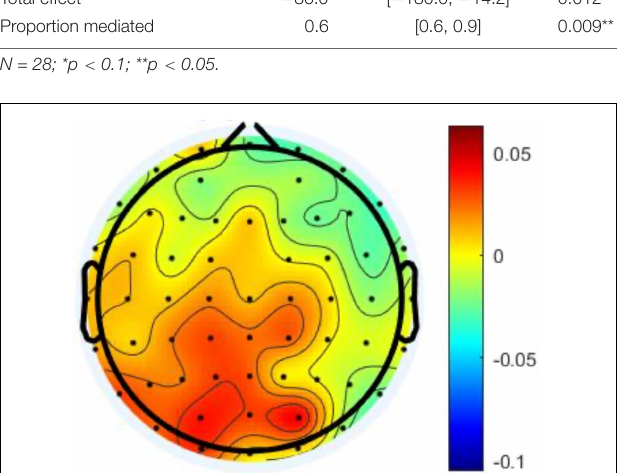
FIGURE 4 | The topography demonstrates the differences of the alpha power between two studied